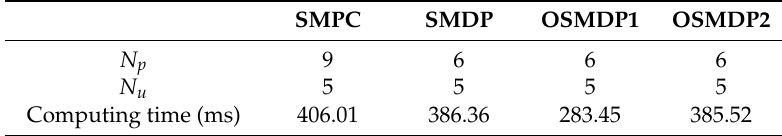
Table 2. The parameters for 4 control algorithms and computing